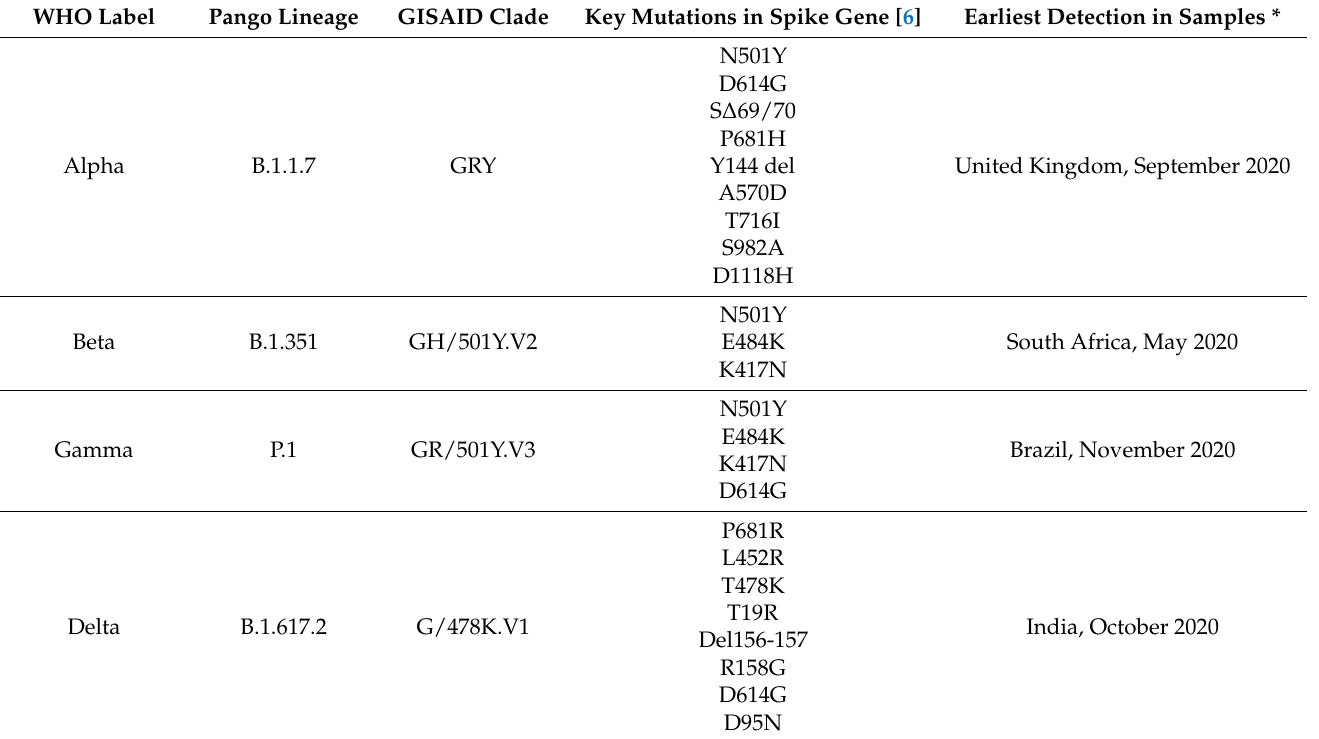
Table 1. Overview of the variants of concern and key mutations. (*): Source of date of earliest detection: https://www.who.int/en/activities/tracking-SARS-CoV-2-variants/ (accessed on 7 February 2022). GISAID Clade Key Mutations in Spike Gene [6] Earliest Detection in Samples